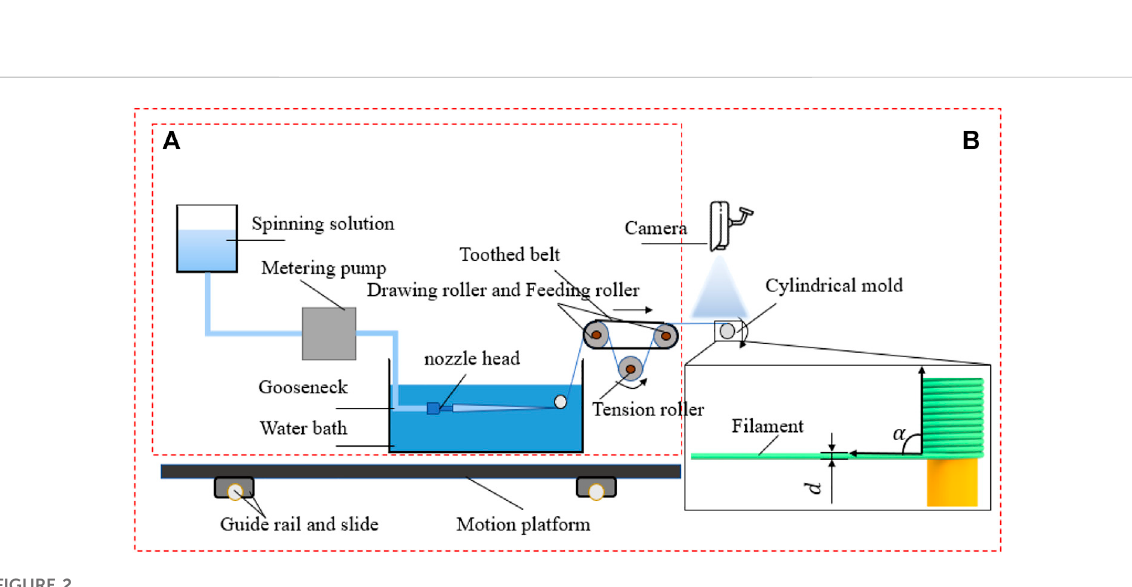
FIGURE 2 Schematic diagram of PU tube preparation